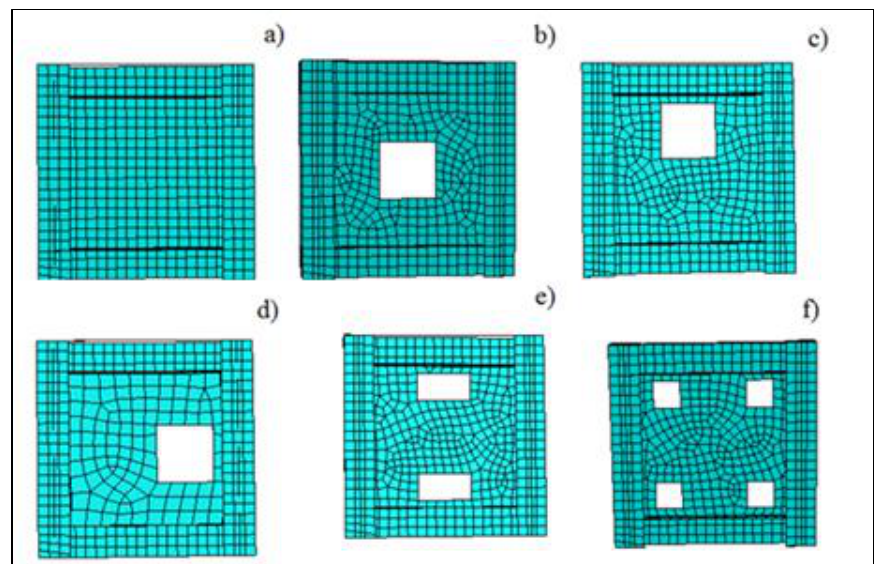
Figure 5. Different position of opening studied in this paper model ( a ) without opening; ( b ) central opening; ( c ) near beam; ( d ) near to column; ( e ) two opening; and ( f ) four opening for group ( a ).